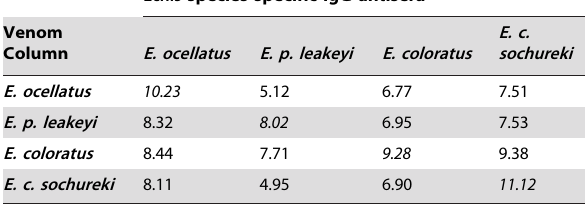
Table 2. Venom affinity-chromatography to measure the binding strength of each Echis species-specific antisera to each venom.